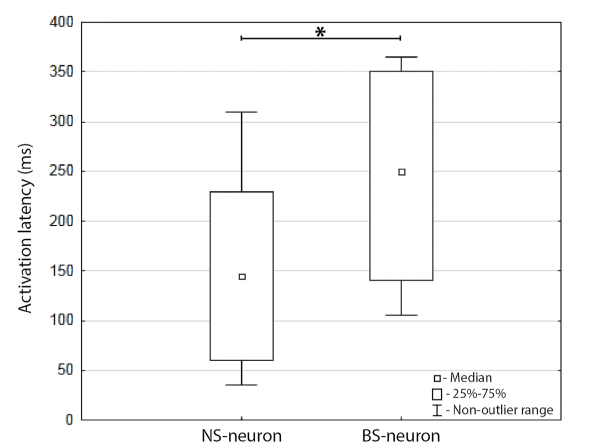
Figure 3. Neuronal activation latencies after the flash. NS – narrow selective neurons, BS – broadly selective